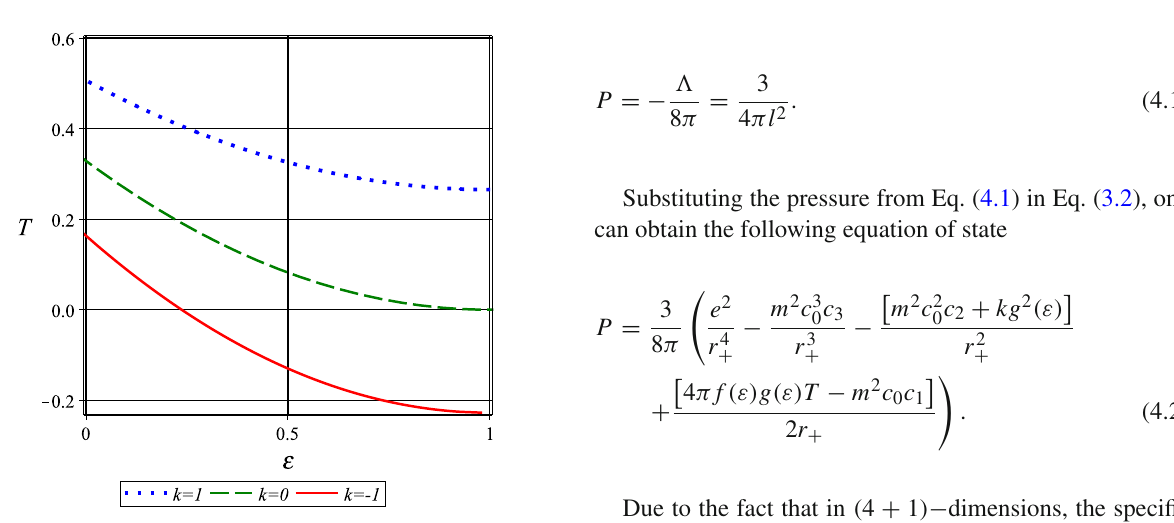
Fig. 9 Typical behavior of the temperature in the third model (Eq. (3.21)), for unit value for all model parameters